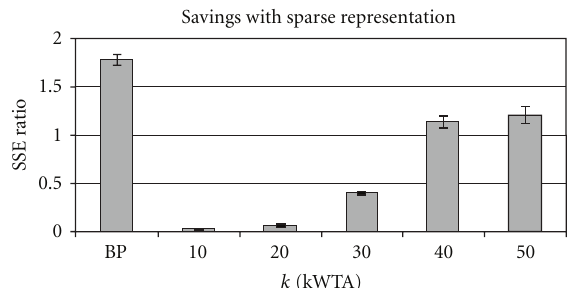
Figure 2: Savings as a function of sparsity. An SSE ratio of one or more indicates no savings, while lower values indicate retention of Base Task knowledge. Nothing Same Task was used as the interfering task. The k parameter roughly equals the percentage of active units in the hidden layer. Error bars display standard errors of the mean.